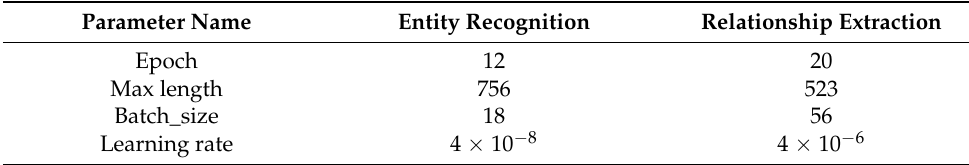
Table 8. The main parameter settings.